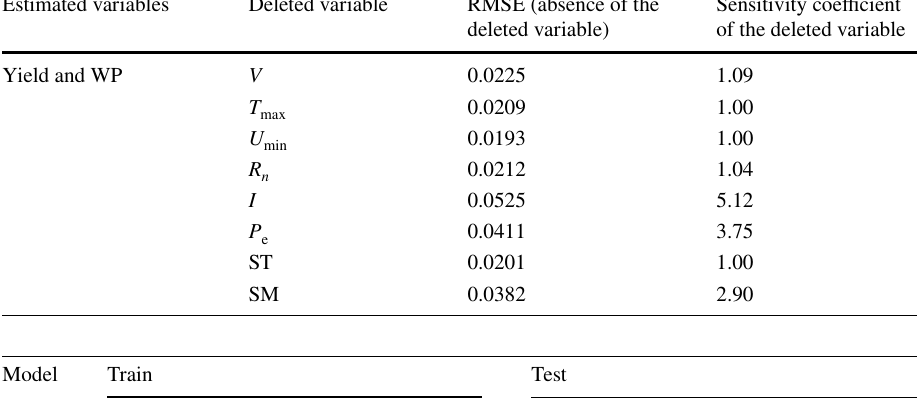
Table 8 Evaluation of the proposed technique in estimating WP and yield